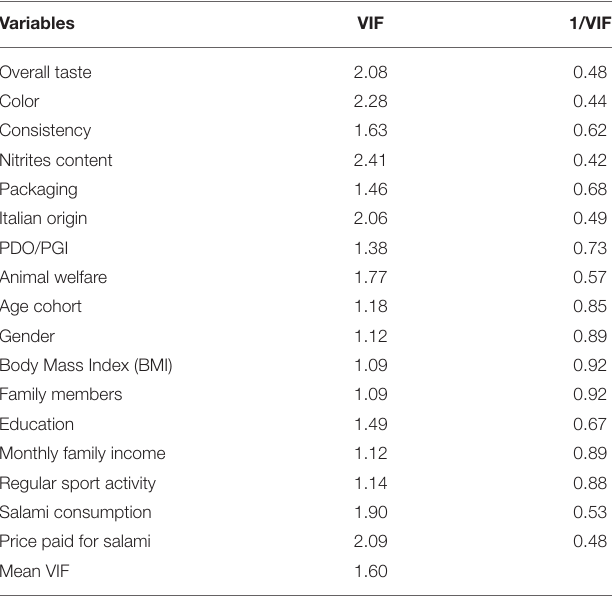
TABLE 4 | Variance Inflation Factor (VIF) analysis of the